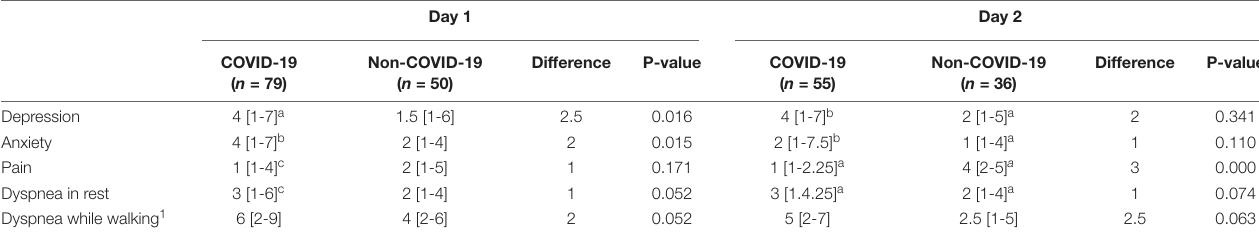
TABLE 5 | Visual Analog Scale (VAS) for depression, anxiety, pain and